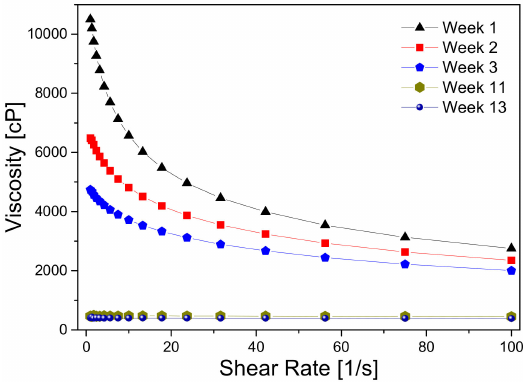
Figure 8. Viscosity variation of the 2 wt % CS/8 wt % PVA solution.